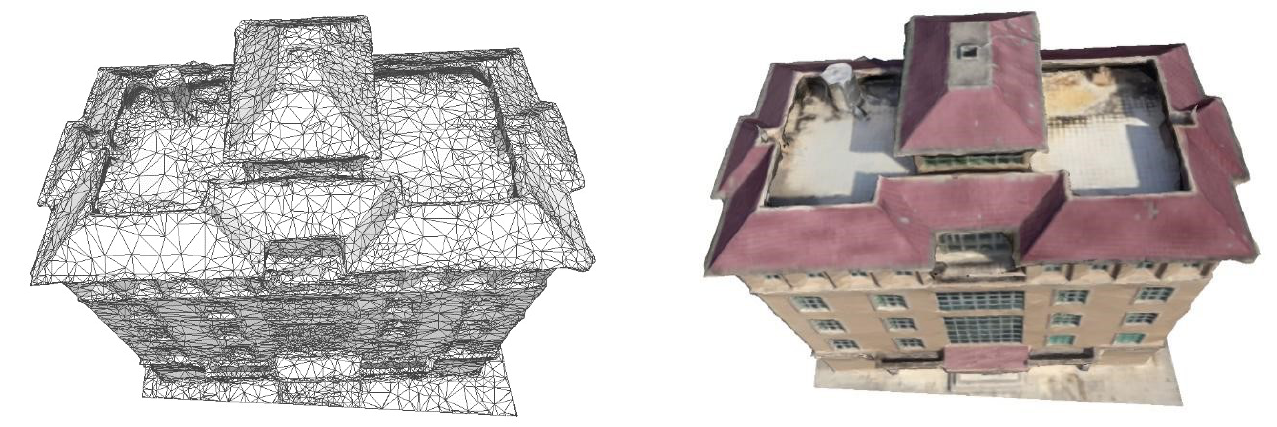
Figure 10. Original meshes (36,841 faces).